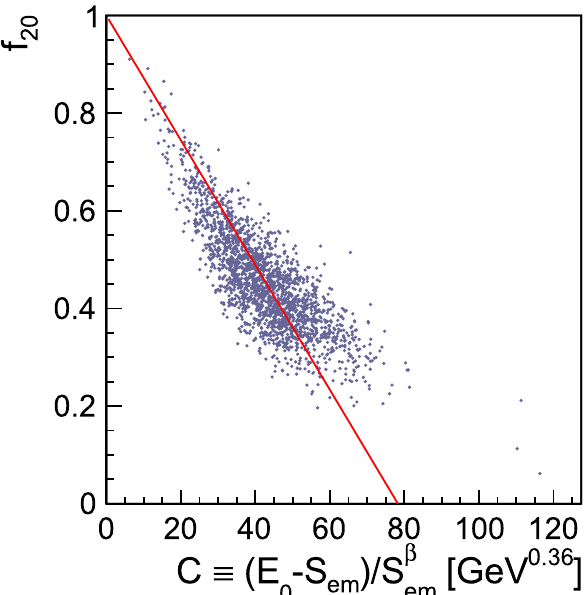
Fig. 13 Correlation of the slope of the calibration lines represented in Fig. 12 with X max , for different S em bins (see